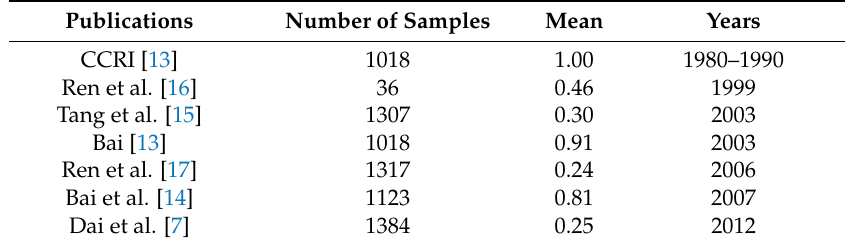
Table 1. Cadmium abundance in Chinese coals according to different authors (unit: µ g/g). Publications Number of Samples Mean Years 1018